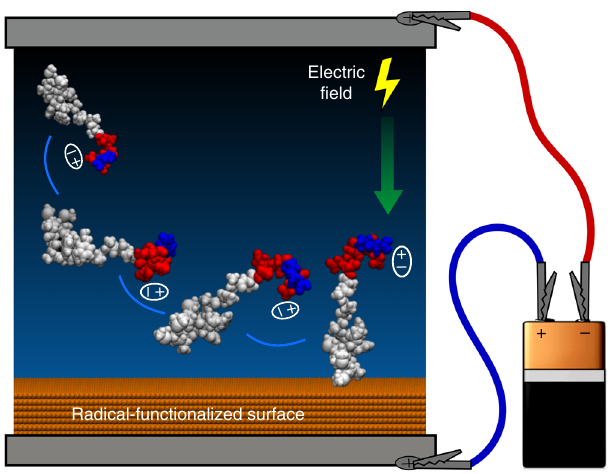
Fig. 1 Control of peptide orientation by electric fi eld. Charge separation on one end of the peptide creates a dipole moment (indicated by ellipses) that aligns with the electric fi eld and rotates the entire molecule. Once contact is established with the radical-functionalized surface, covalent linkage anchors the peptide in this